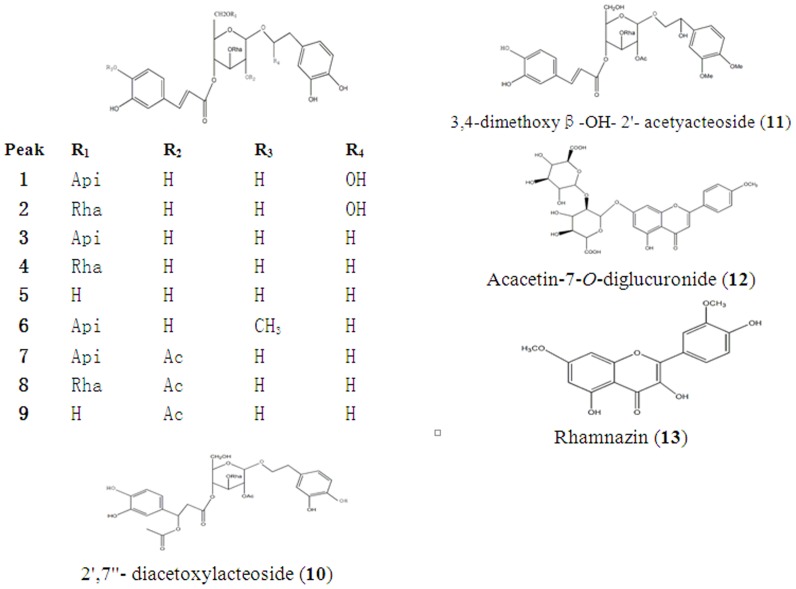
Chemical structures of 13 compounds identified from CK (Api, apiosyl; Rha, rhamnosyl; Ac, acetyl moiety).